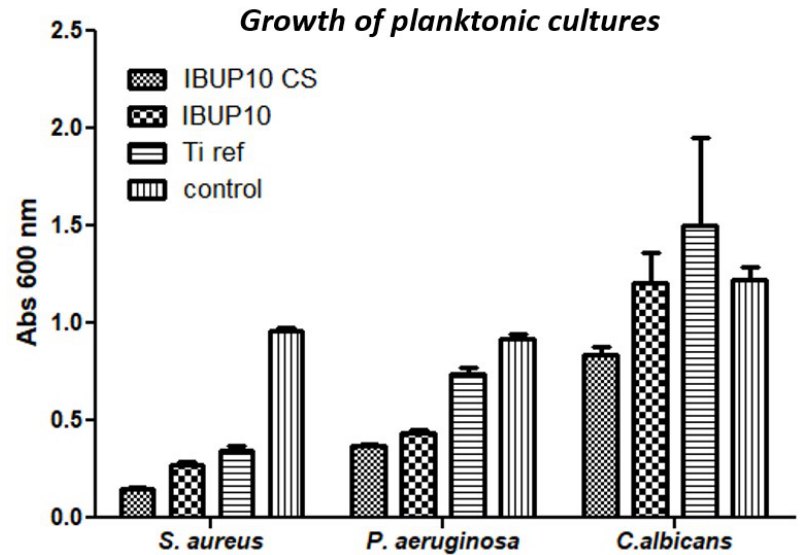
Figure 10. Growth evaluation of planktonic cultures of S. aureus , P. aeruginosa, and C. albicans in the presence of coatings of composite biopolymeric spheres.